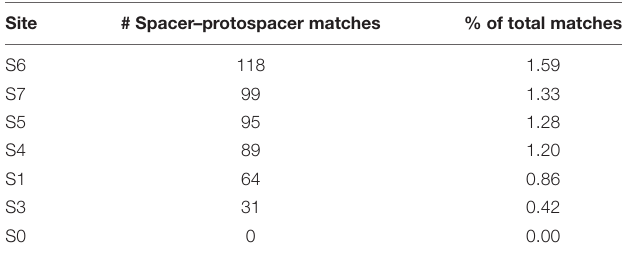
TABLE 3 | Proportion of protospacer hits falling within the defined bont and cas associated gene clusters.